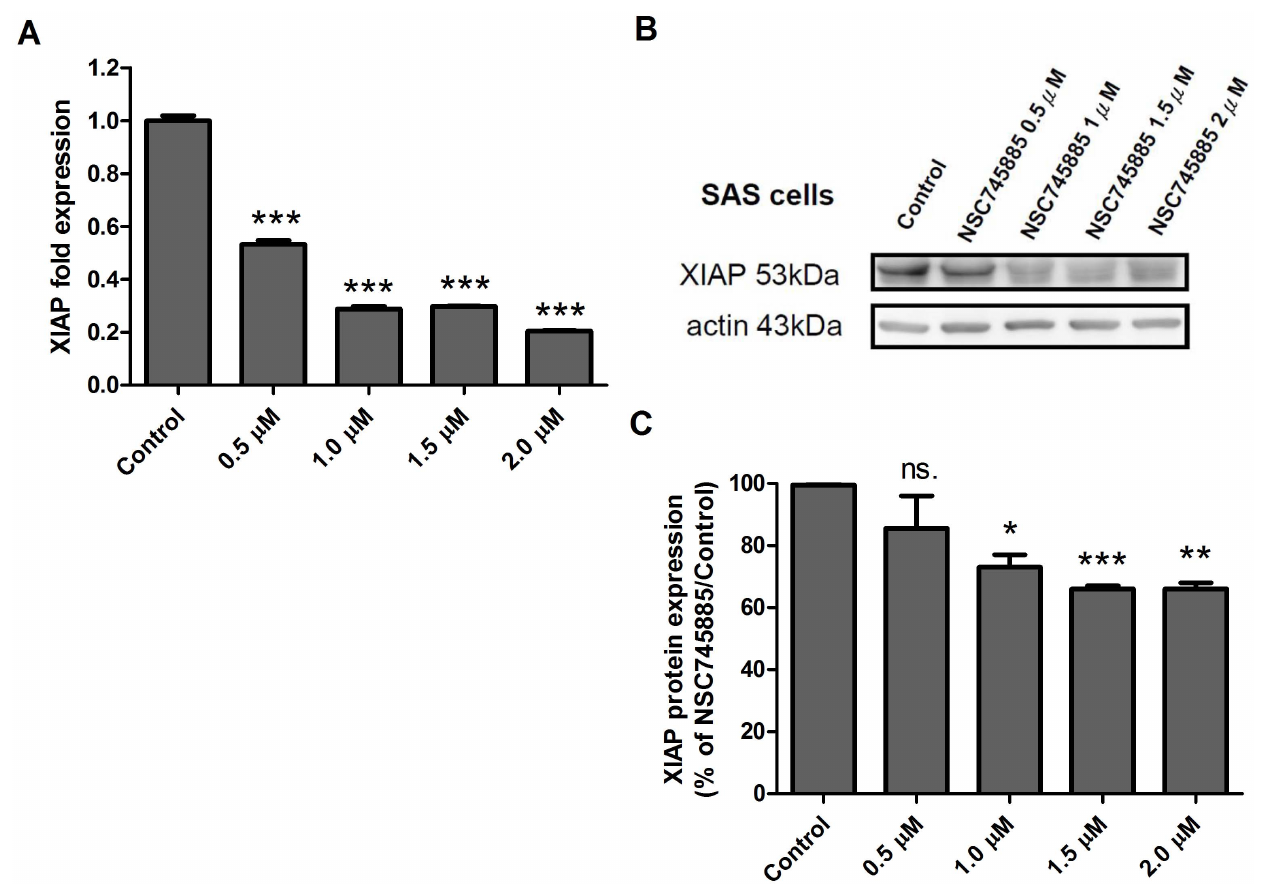
Figure 5. NSC745885 treatment decreased the RNA and protein levels of XIAP in SAS cells. The relative RNA expression level of XIAP in SAS cells treated with indicated dosages of NSC745885 was evaluated at 24 hours using real-time RT-PCR. The expression of XIAP significantly decreased with NSC745885 treatment in a dose-dependent manner. (B) The expression of XIAP in SAS cells treated with NSC745885 was quantified using western blot at 48 hours of treatment. (C) The western blot results were evaluated in 3 independent experiments and normalized with b -actin (*, P , 0.05; **, P , 0.01; ***, P , 0.001). The protein level of XIAP decreased in a dose-dependent manner.